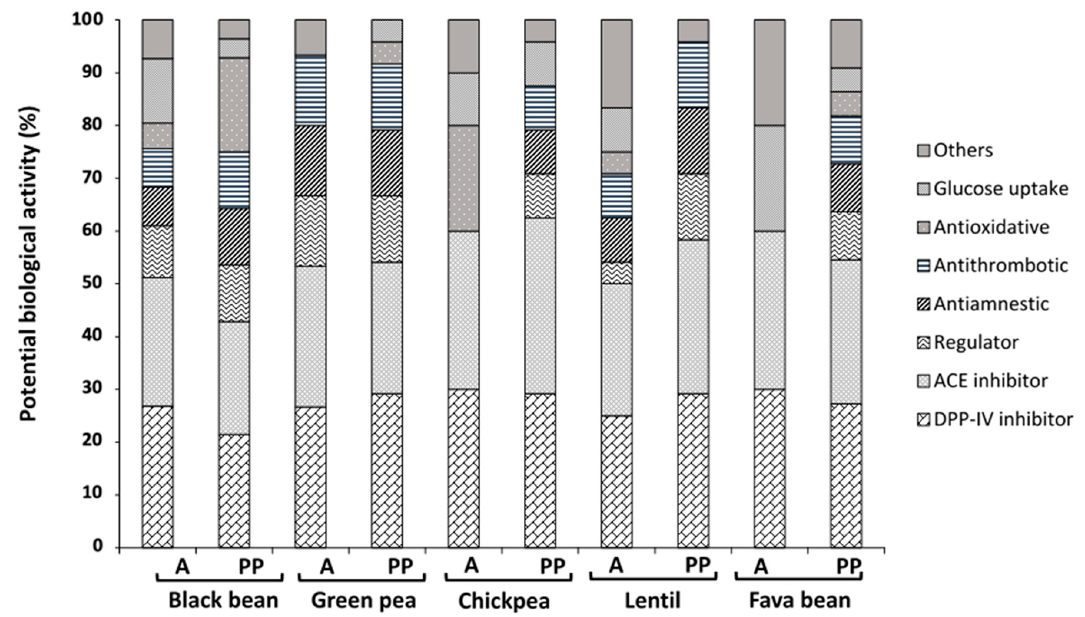
Figure 2. Potential biological activity (%) of different legume-generated peptides using Biopep database. PP, pepsin/pancreatin; A, alcalase; DPP-IV, dipeptidyl peptidase IV inhibitor; ACE, angiotensin-converting enzyme inhibitor; regulator, stomach mucosal membrane activity regulator. Results represent the mean ± SD of at least two independent experiments.